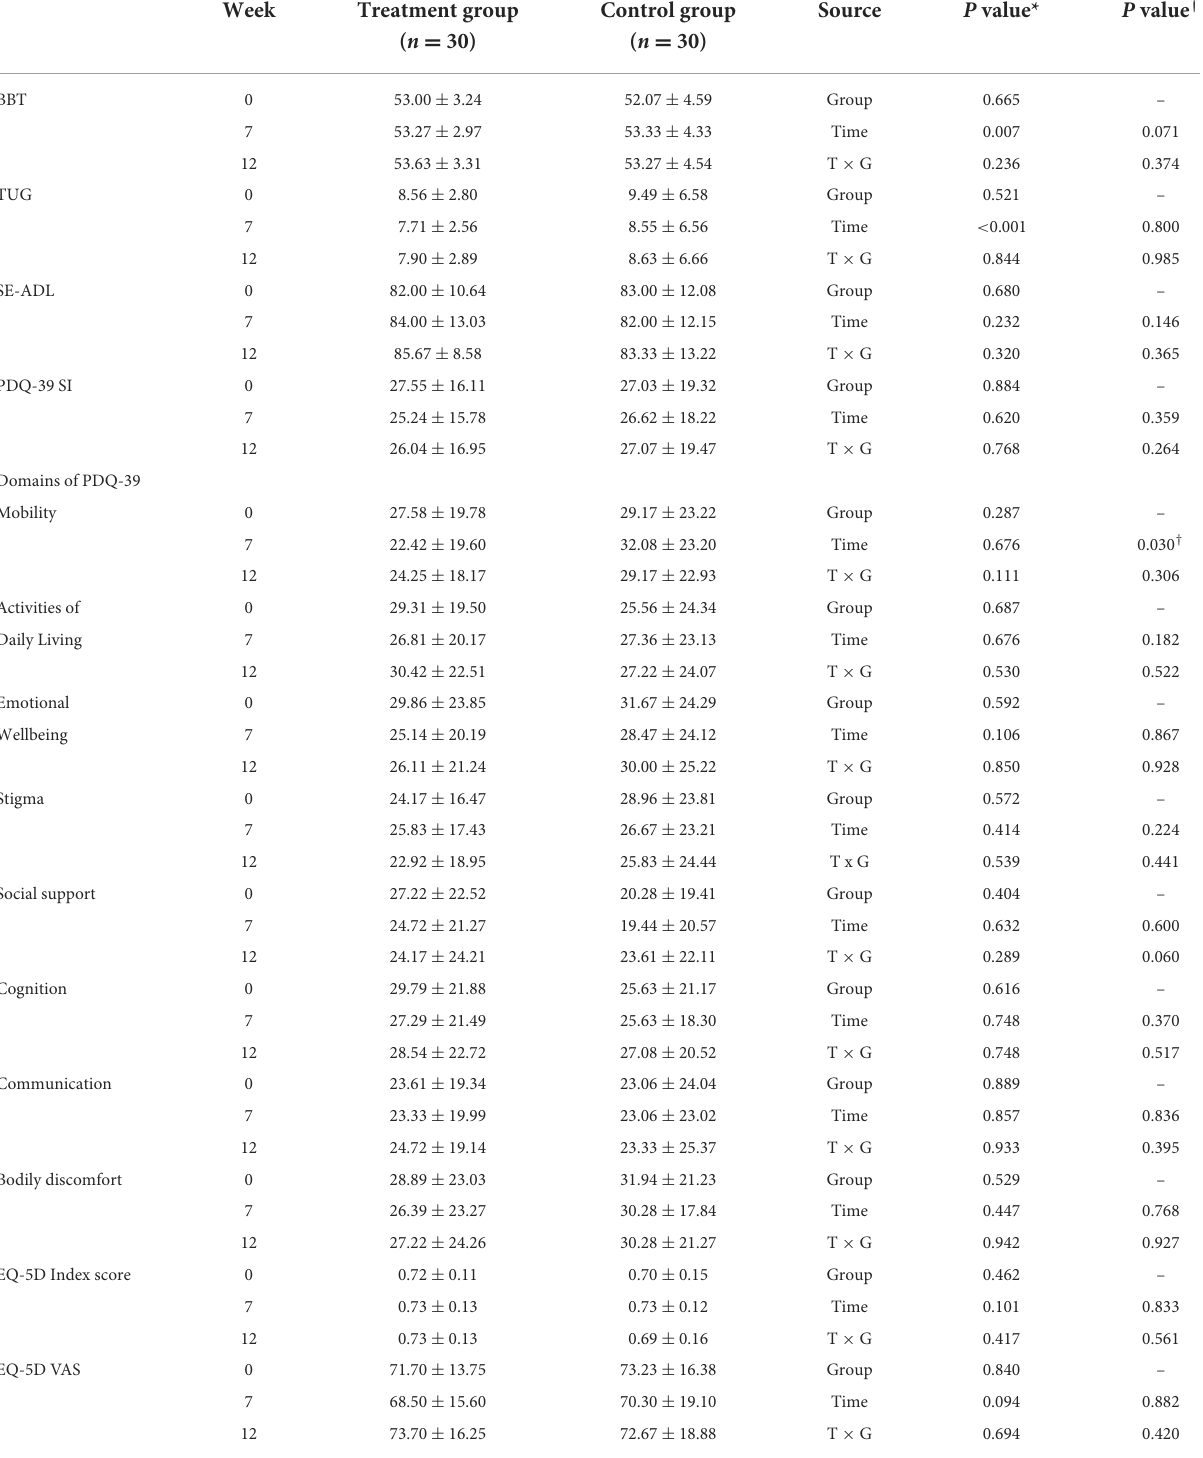
TABLE 7 Comparison of other outcomes between two